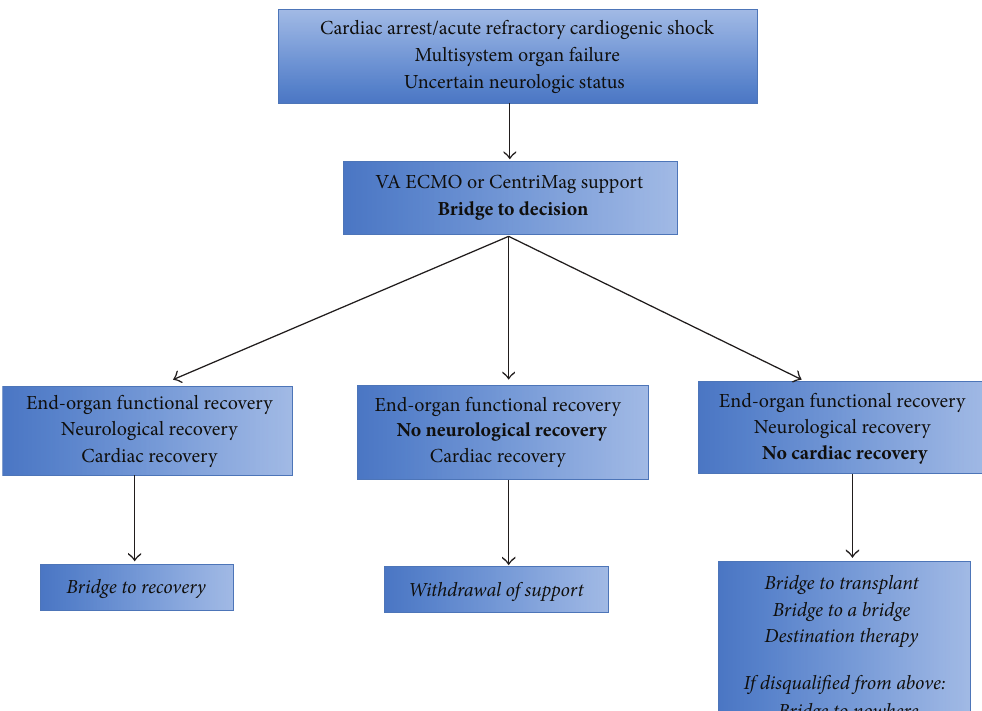
Figure 1: VA ECMO support after cardiac arrest provides hemodynamic stabilization, which allows time for therapeutic hypothermia and assessment of the neurologic status of the patient. If the patient achieves both neurologic and cardiac recovery, VA ECMO support will have functioned as a bridge to recovery and can subsequently be removed. If the patient does not recover neurologic function, VA ECMO support is typically withdrawn. If the patient awakens but does not have recoverable myocardial function, candidacy for heart transplant (bridge to transplant) and temporary (bridge to a bridge) or permanent (destination therapy) implantation of a ventricular assist device can be assessed. The neurologically intact patient that is disqualified from a heart transplant or ventricular assist device presents a dilemma that may be described as a bridge to nowhere. Figure adapted from